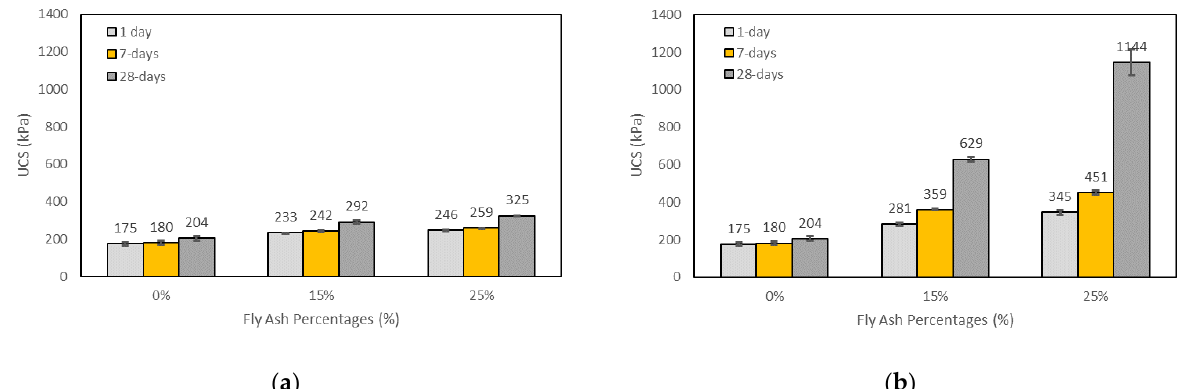
Figure 9. Effects of fly ash content on the UCS of ( a ) soils stabilised with neat fly ash and ( b ) soils stabilised with alkali-activated fly ash with an M+ of 12% and an SM of 1.25 and with different curing times.